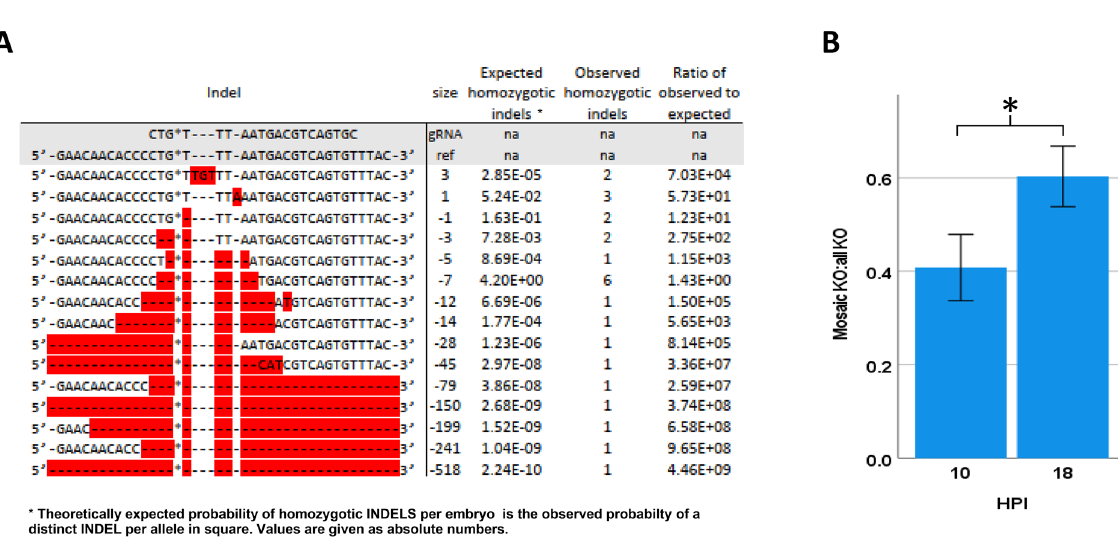
Figure 2. ( A ) Sequence details of all Homozygous Full edit editing events (n = 21) represented by a total of 15 INDEL editing variants. The probability of Loss-of-heterozygosity for of all these 15 INDEL variants involving both homologous chromosomes is far above expected plausibility based on likelihood of observed INDELS in single chromosomes suggesting a distinct mechanistic cause rather than random effects. ( B ) Effects of early (n = 131) and late (n = 213) electroporation (10 vs. 18 HPI) on mosaic edit to all edit ratio. Earlier electroporation resulted in a significantly lower mosaic edit to all edit ratio compared to later electroporation. *Denotes significant difference (p < 0.05) between